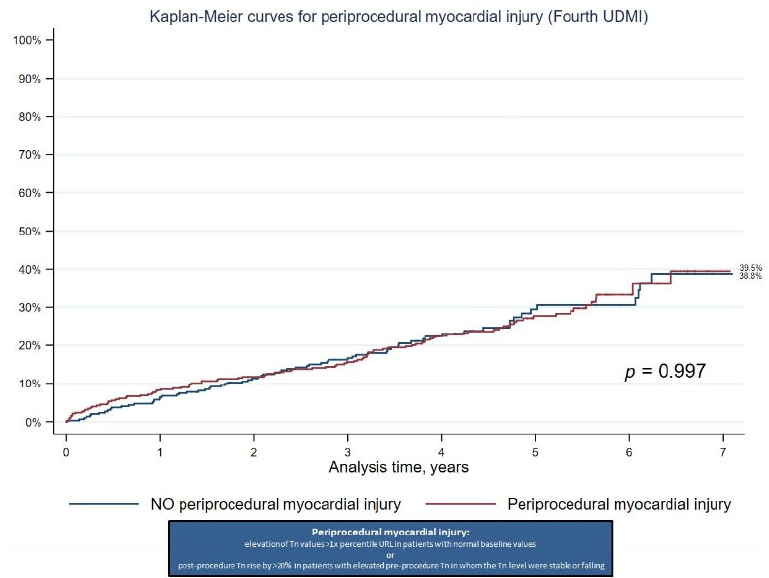
Figure 3. Kaplan-Meier analysis of all-cause mortality: Periprocedural myocardial injury vs. NO periprocedural myocardial injury (Fourth Universal Definition of Myocardial Infarction).